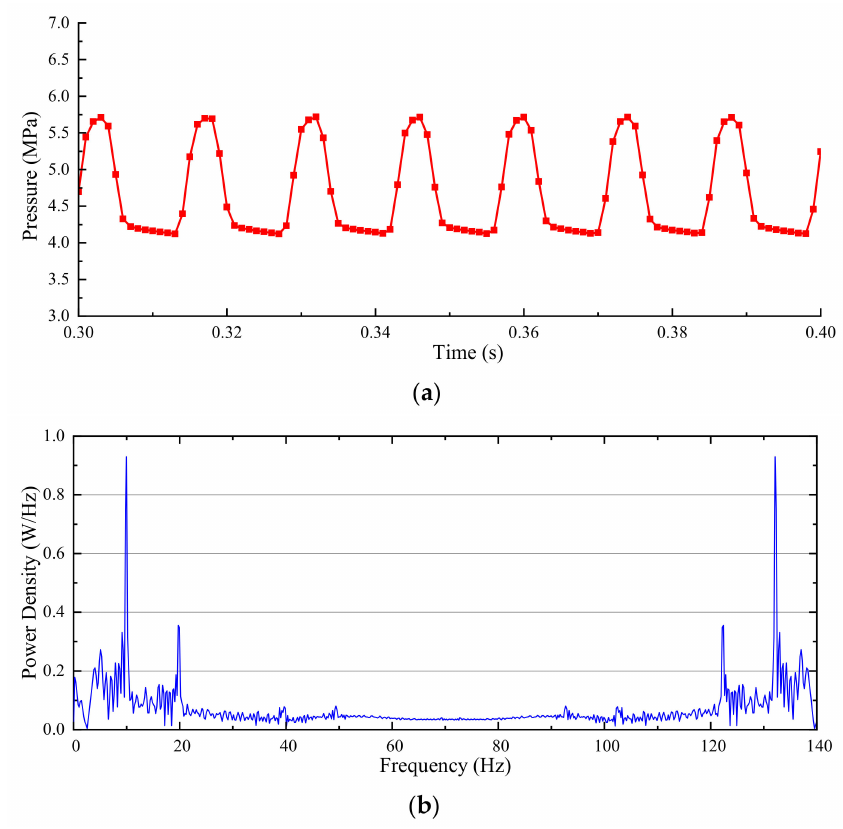
Figure 13. Pressure fluctuations of point 1 at inlet pressure 21 MPa: ( a ) Fluctuation in time domain; ( b ) Spectrum